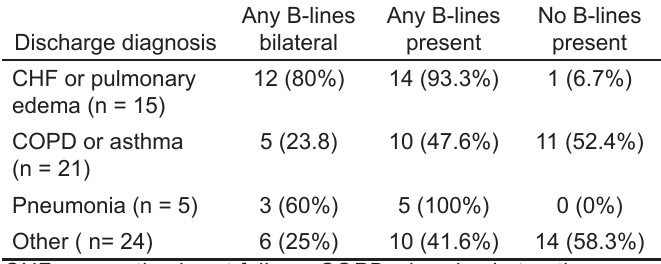
CHF, congestive heart failure; COPD, chronic obstructive pulmonary